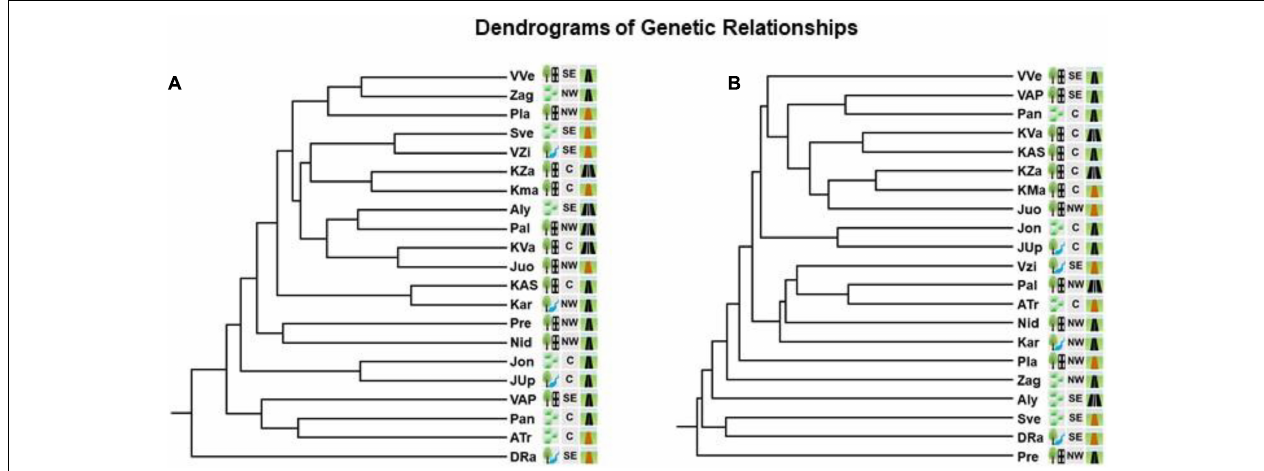
FIGURE 4 | Dendrograms based on UPGMA cluster analysis of Nei’s genetic distances at ISSR loci (A) and RAPD loci (B) of genetic relationships between the populations of Impatiens parviflora . Three letters denote the populations (for details of their location, see Figure 1 . Explanations of the pictogram are provided in the Table 1